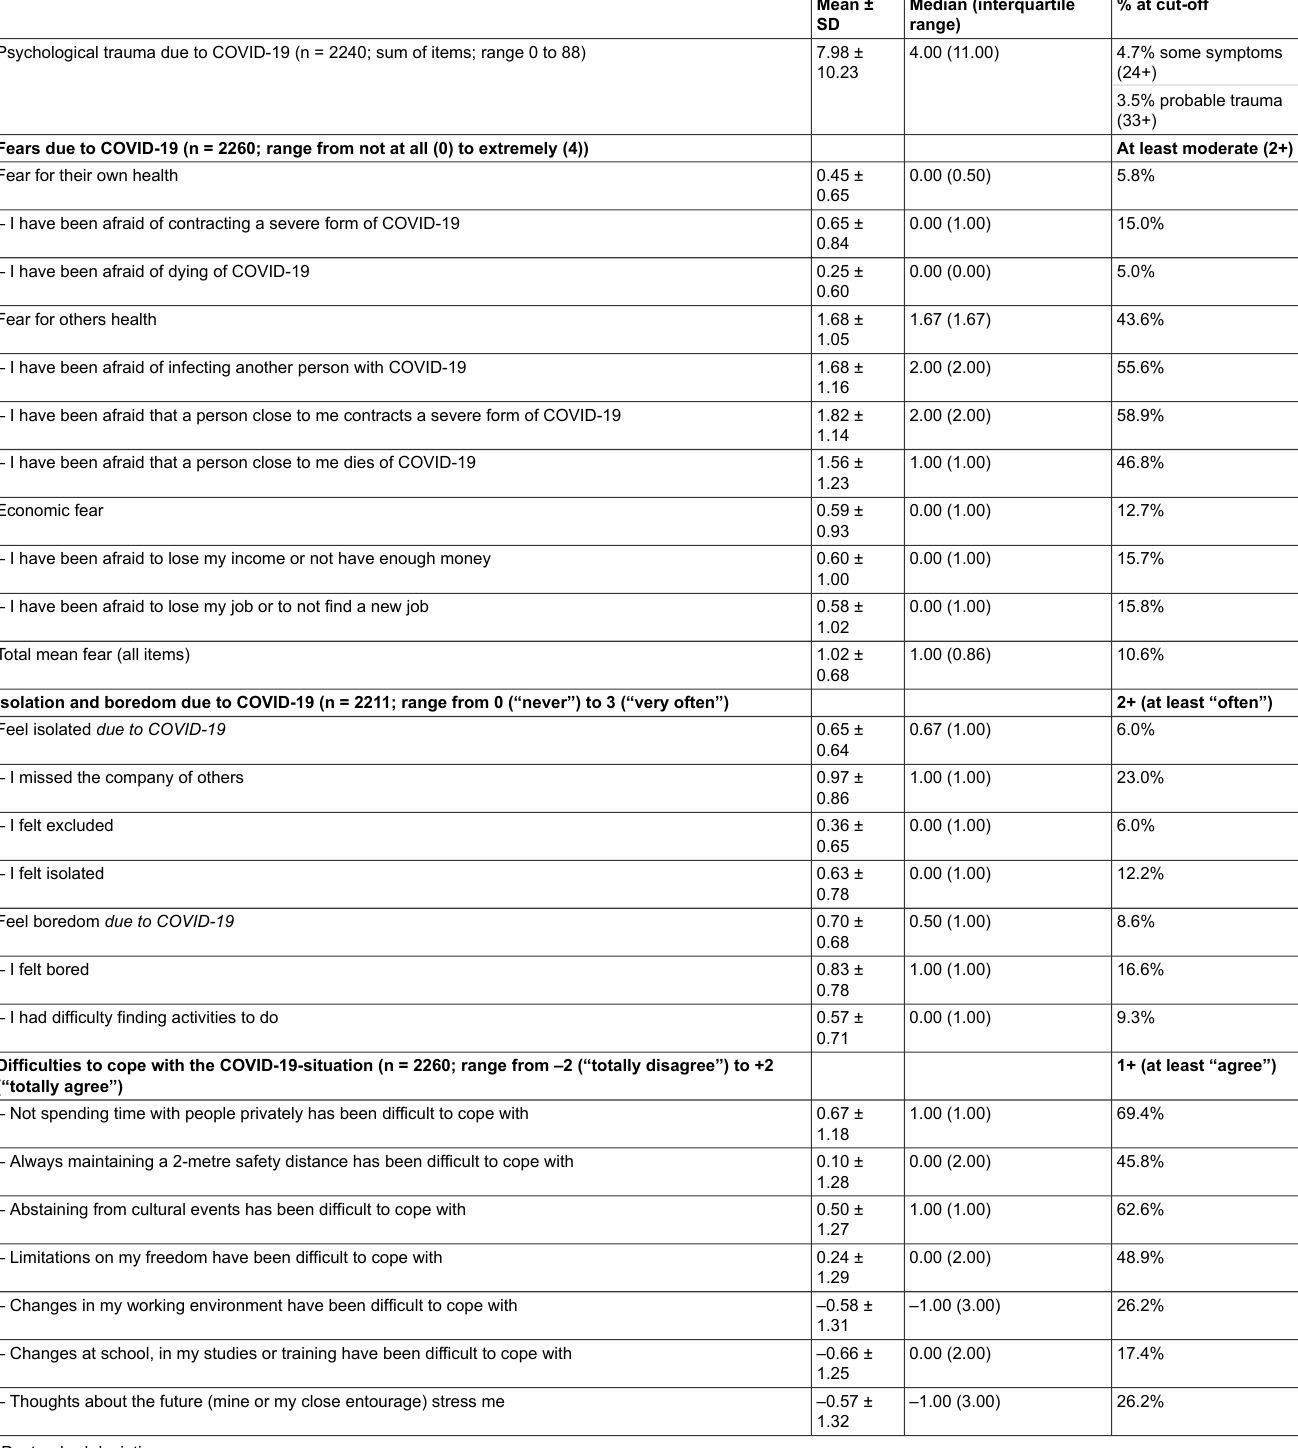
Table 3: Descriptive statistics of the psychological consequences of COVID-19 with mention of it as a cause.